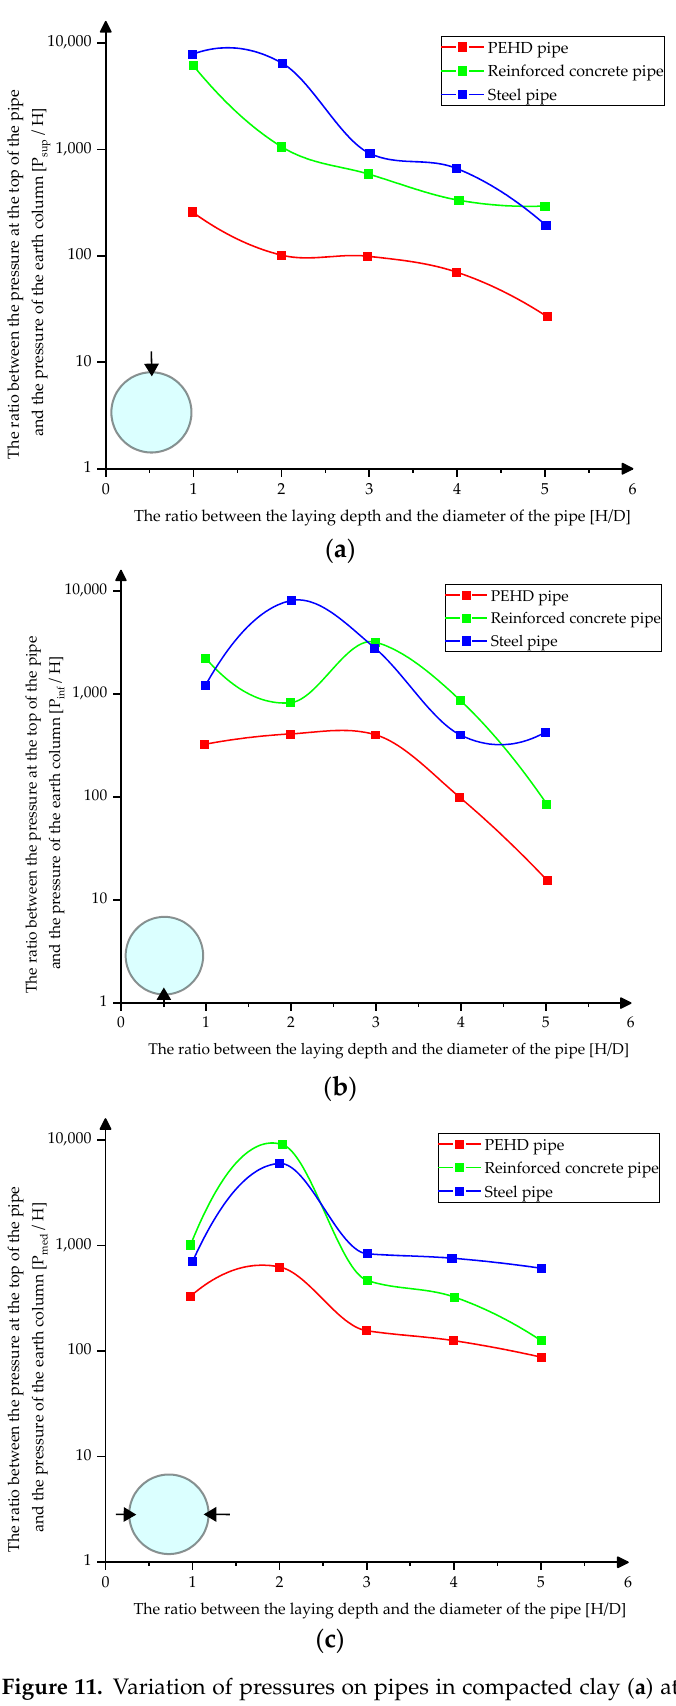
Figure 10. Variation of pressures on pipes in compacted sands ( a ) at the top of the pipes ( b ) at the bottom of the pipes ( c ) in middle sections